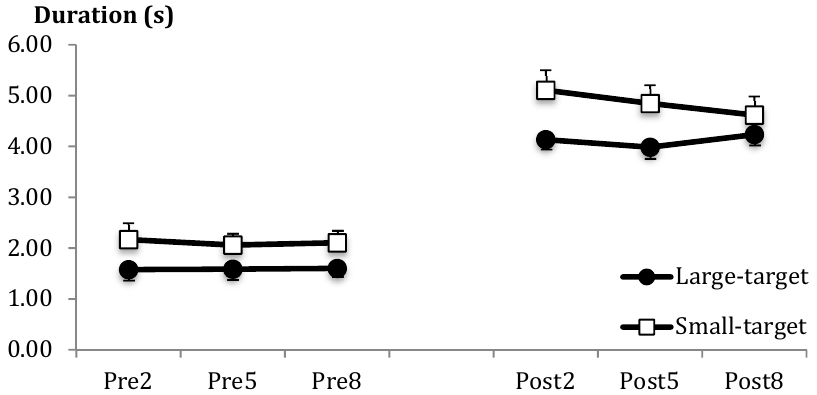
Figure 5. Mean duration (and SE bars) as a function of pre-throw (Pre) and post-throw (Post) periods for blocks 2, 5, and 8.